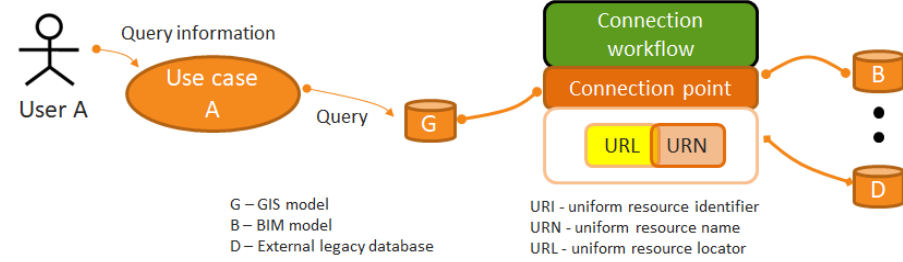
Figure 14. Information connection approach for element data synchronization, propagation-enabled.